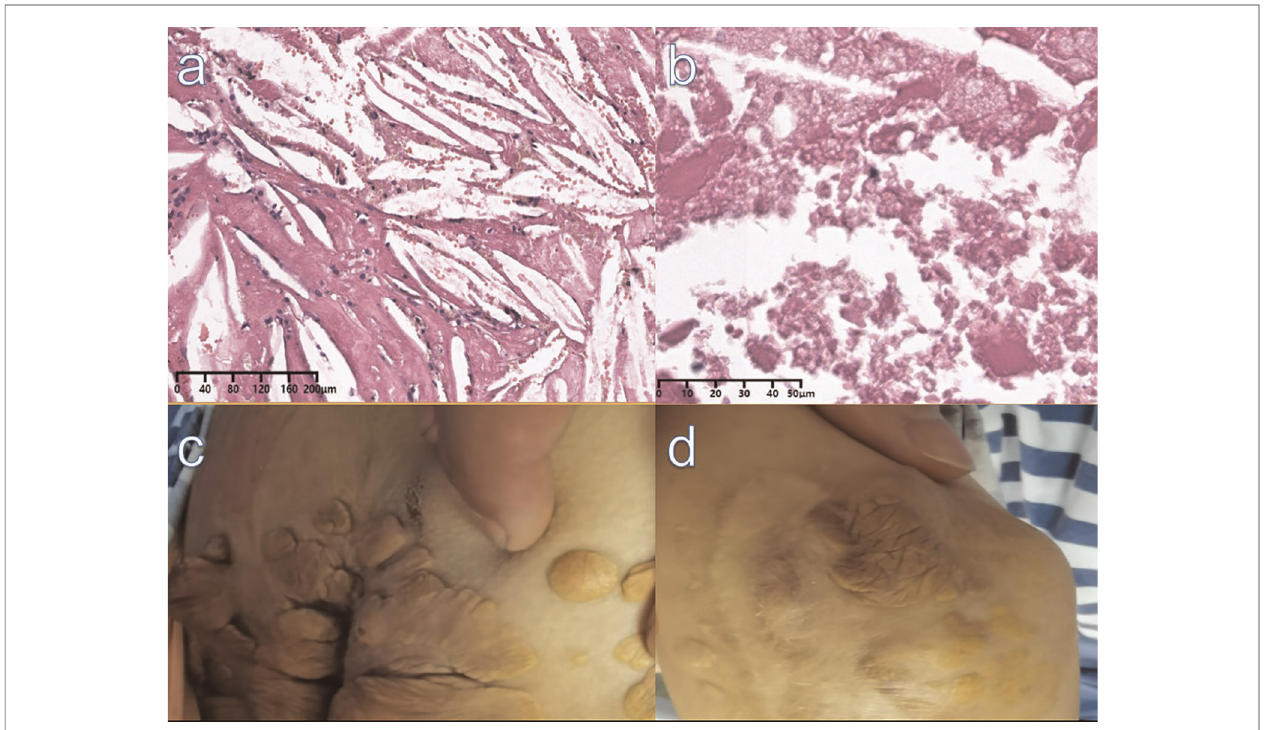
FIGURE 2 | ( A ) (H&E,X10), ( B ) (H&E,X40): Pathology showed fi brous tissue hyperplasia with abundant cholesterol fi ssures, Foam cell aggregation with necrosis and calci fi cation. ( C ) Xanthomas on the skin of the buttocks. ( D) Scar and residual xanthoma after excision of left elbow